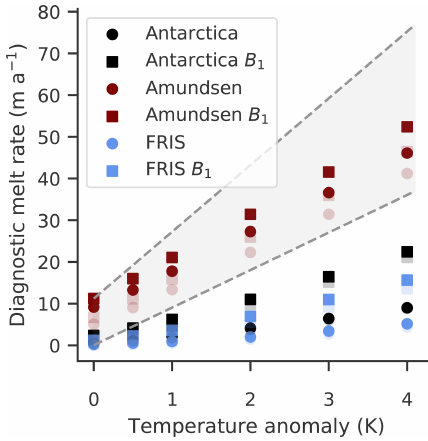
Figure 7. Sensitivity of basal melt rates to ocean temperatures in PICO. Diagnosed from the historic configuration (opaque) and the cold-start configuration (transparent) in 2015 using step-wise ocean temperature increases. Dots show shelf-wide averages while boxes indicate the basal melt rates close to the grounding lines (in PICO box B 1 ). The dashed gray lines indicate the sensitivity estimates used in Levermann et al.